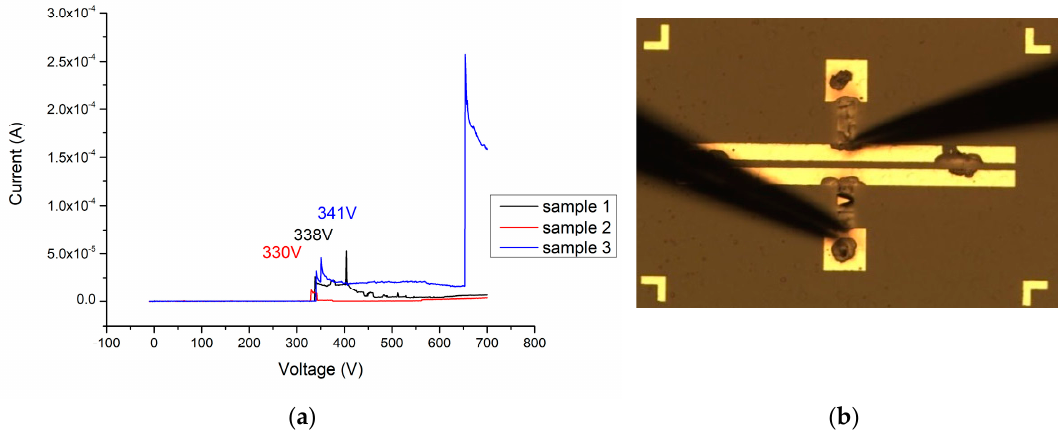
Figure 21. ( a ) I–V measurement results (sample 1 in black, sample 2 in red, and sample 3 in blue) and ( b ) breakdown image of the MOSOM varactor (with a 156 nm thick Ga 2 O 3 thin film) without the annealing process.